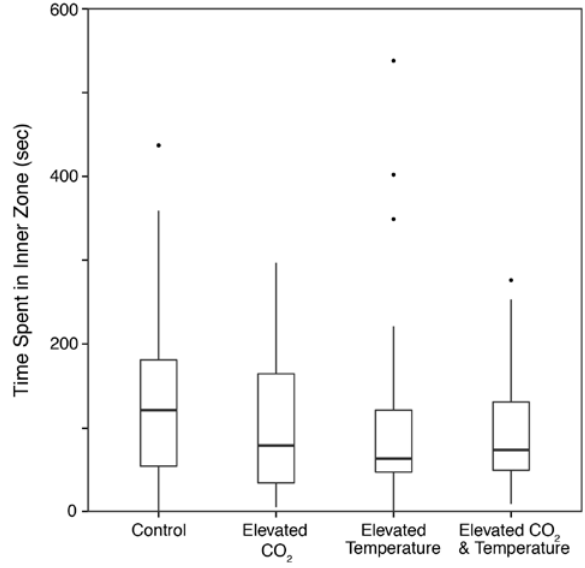
Figure 3. The effect of elevated CO 2 and temperature treatments on the time spent in the inner zone during a 15 min open field test in larval yellowtail kingfish. Boxplots show median and inter-quartile range. N = 29, 38, 29, and 34, respectively.